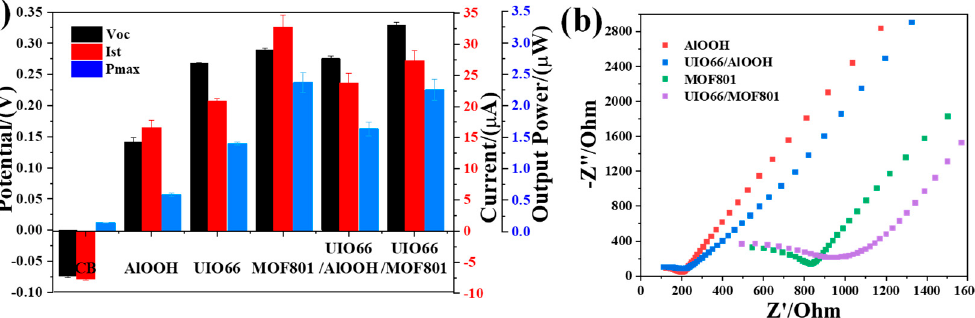
Figure 4. The maximum V oc , I st and P max of different MOFs modified KBF in ( a ) NaCl aqueous solu- tion (0.5 M) and ( b ) EIS Nyquist diagram of AlOOH, UIO66/ AlOOH, MOF801 and UIO66/MOF801. The EIS was performed in 0.25 M KCl solution.